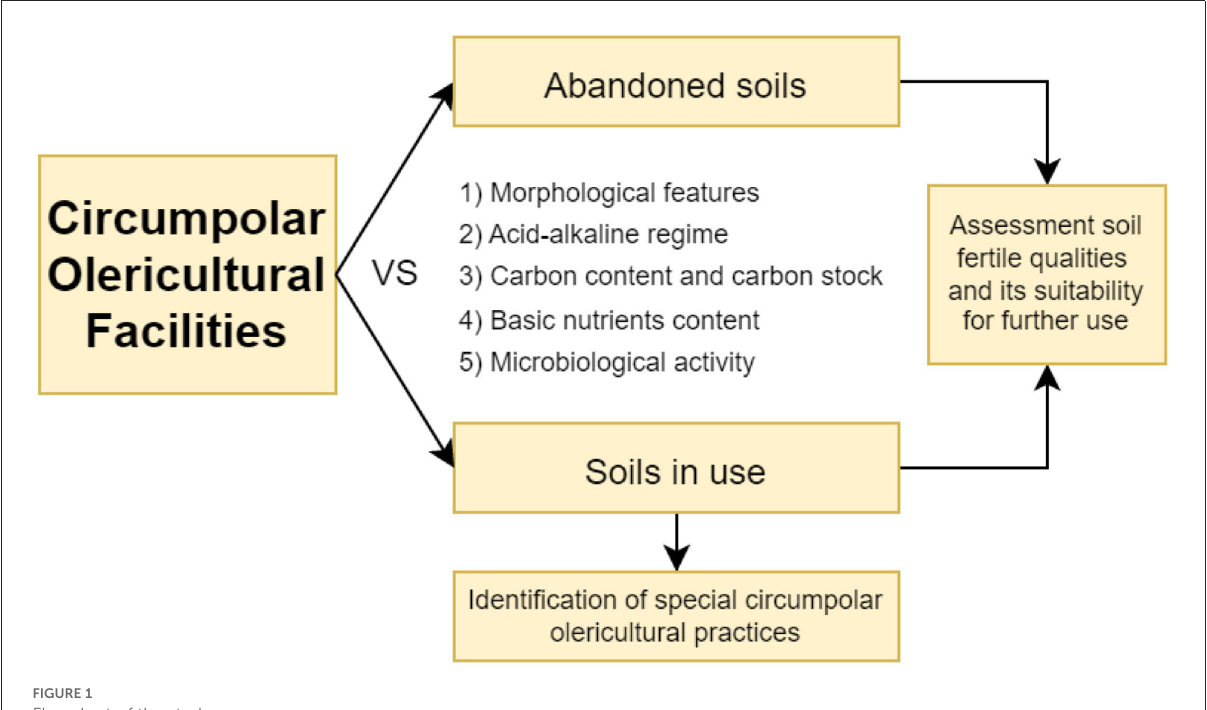
FIGURE1 Flowchart of the